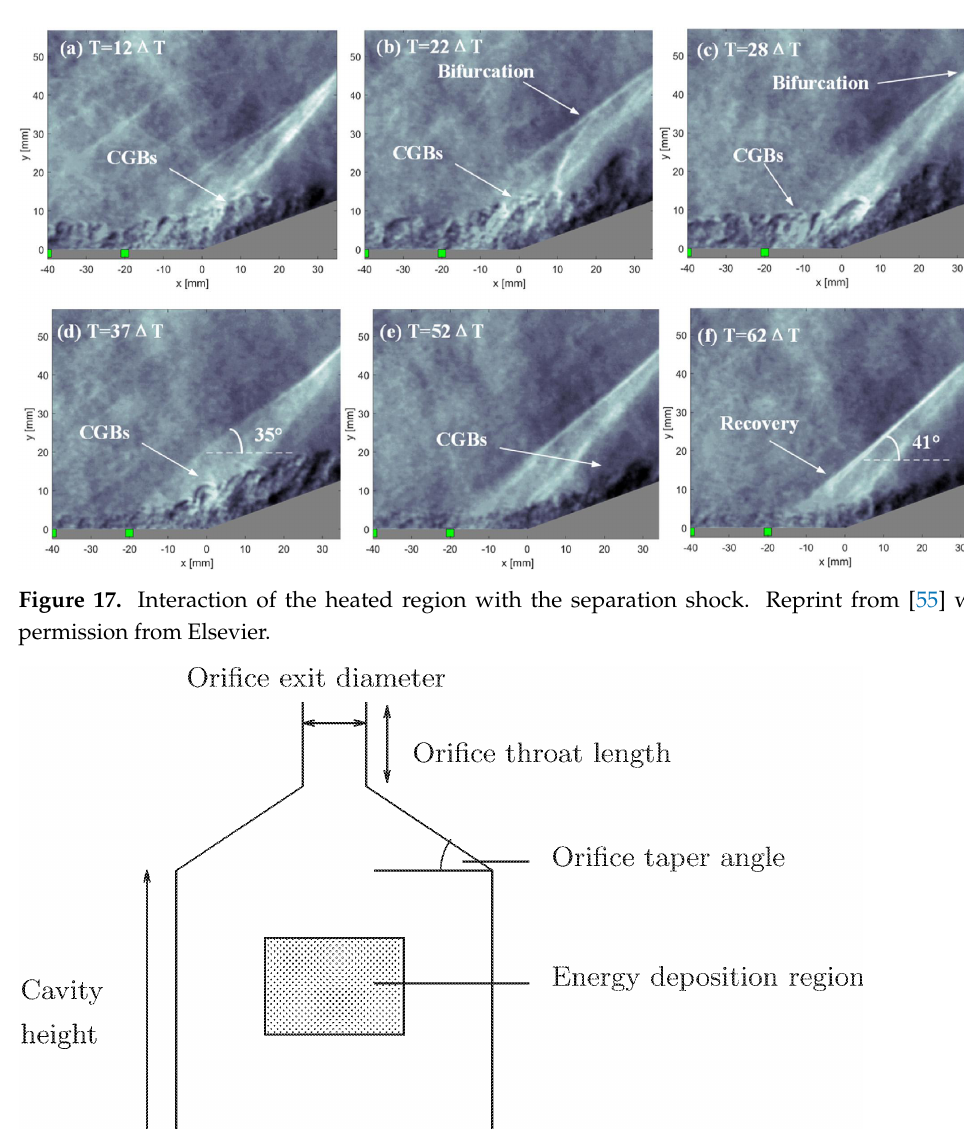
Figure 16. Interaction of the SparkJet induced shock with the separation shock. Reprint from [55] with permission from Elsevier.